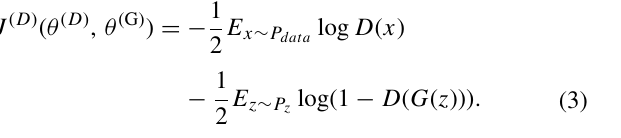
Fig. 1 Typical structure of GAN